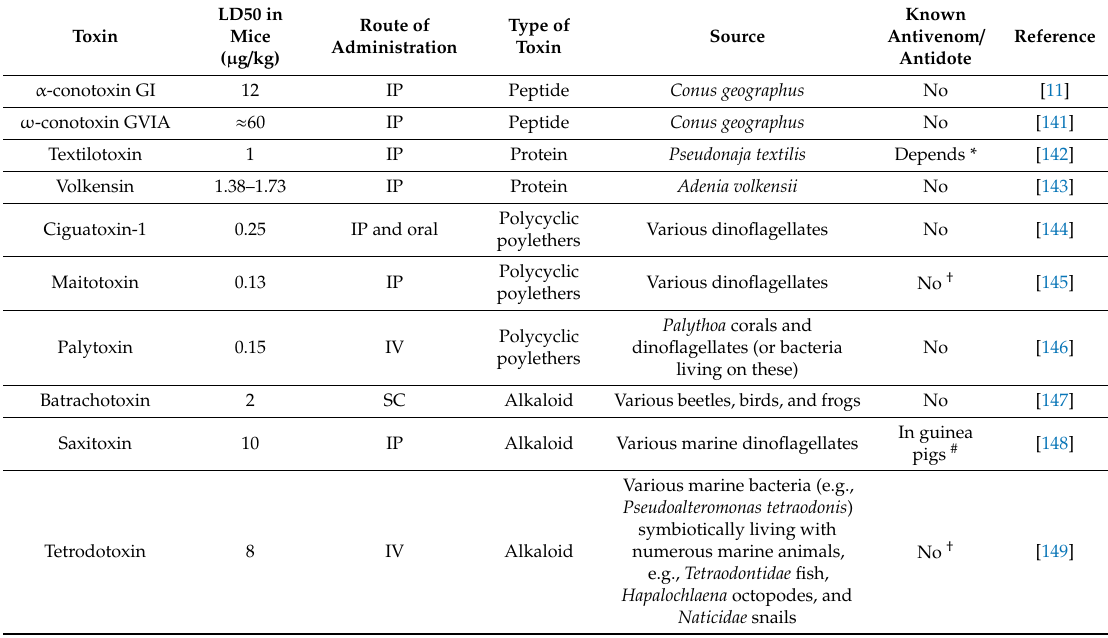
Table 4. Comparison of the median lethal dose (LD 50 ) of di ff erent toxins and toxic